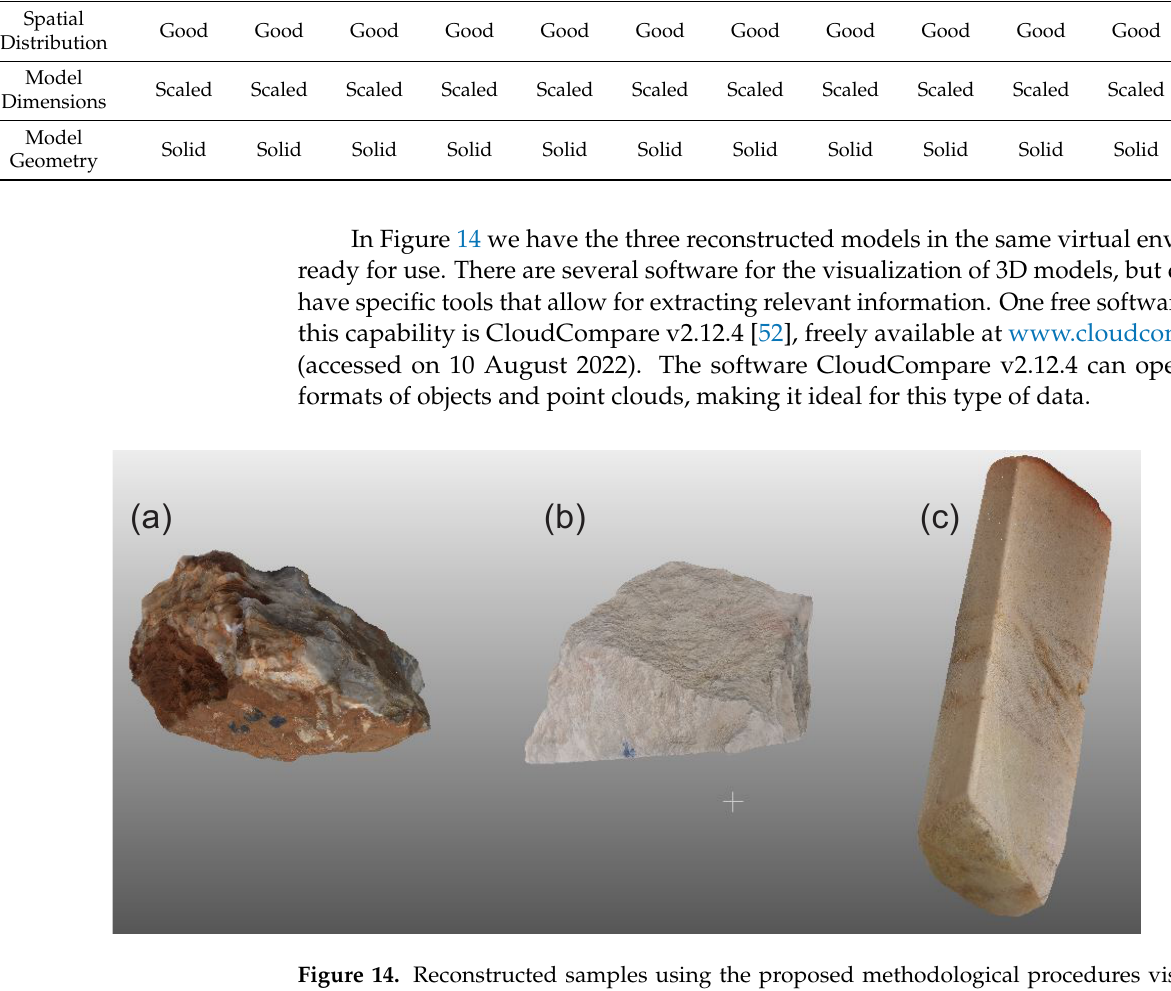
Table 10. Technology Acceptance Model Perceived Usefulness.